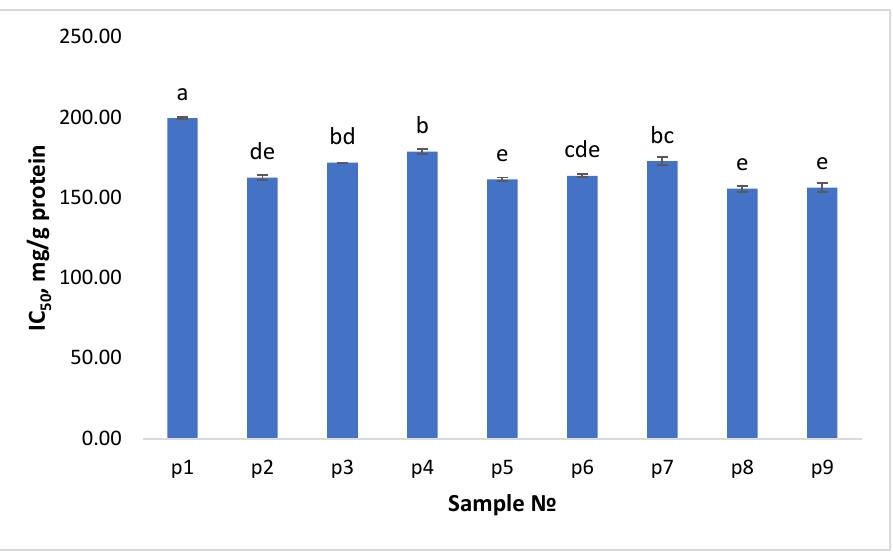
Figure 2. IC 50 of lupin protein hydrolysates toward acetylcholinesterase activity. Values are means ± SEM, n = 3 per treatment group. Different letters (a – e) indicate significant differences ( p < 0.05) between treatments as analyzed by one-way ANOVA and TUKEY test.